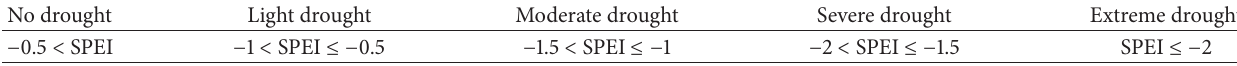
Table 1: Classification standard of drought based on